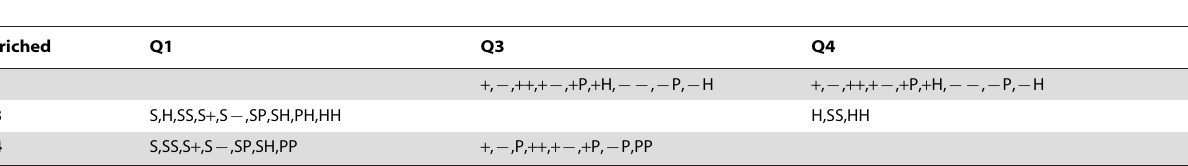
Table 2. Kolmogorov-Smirnov test for crystal contact